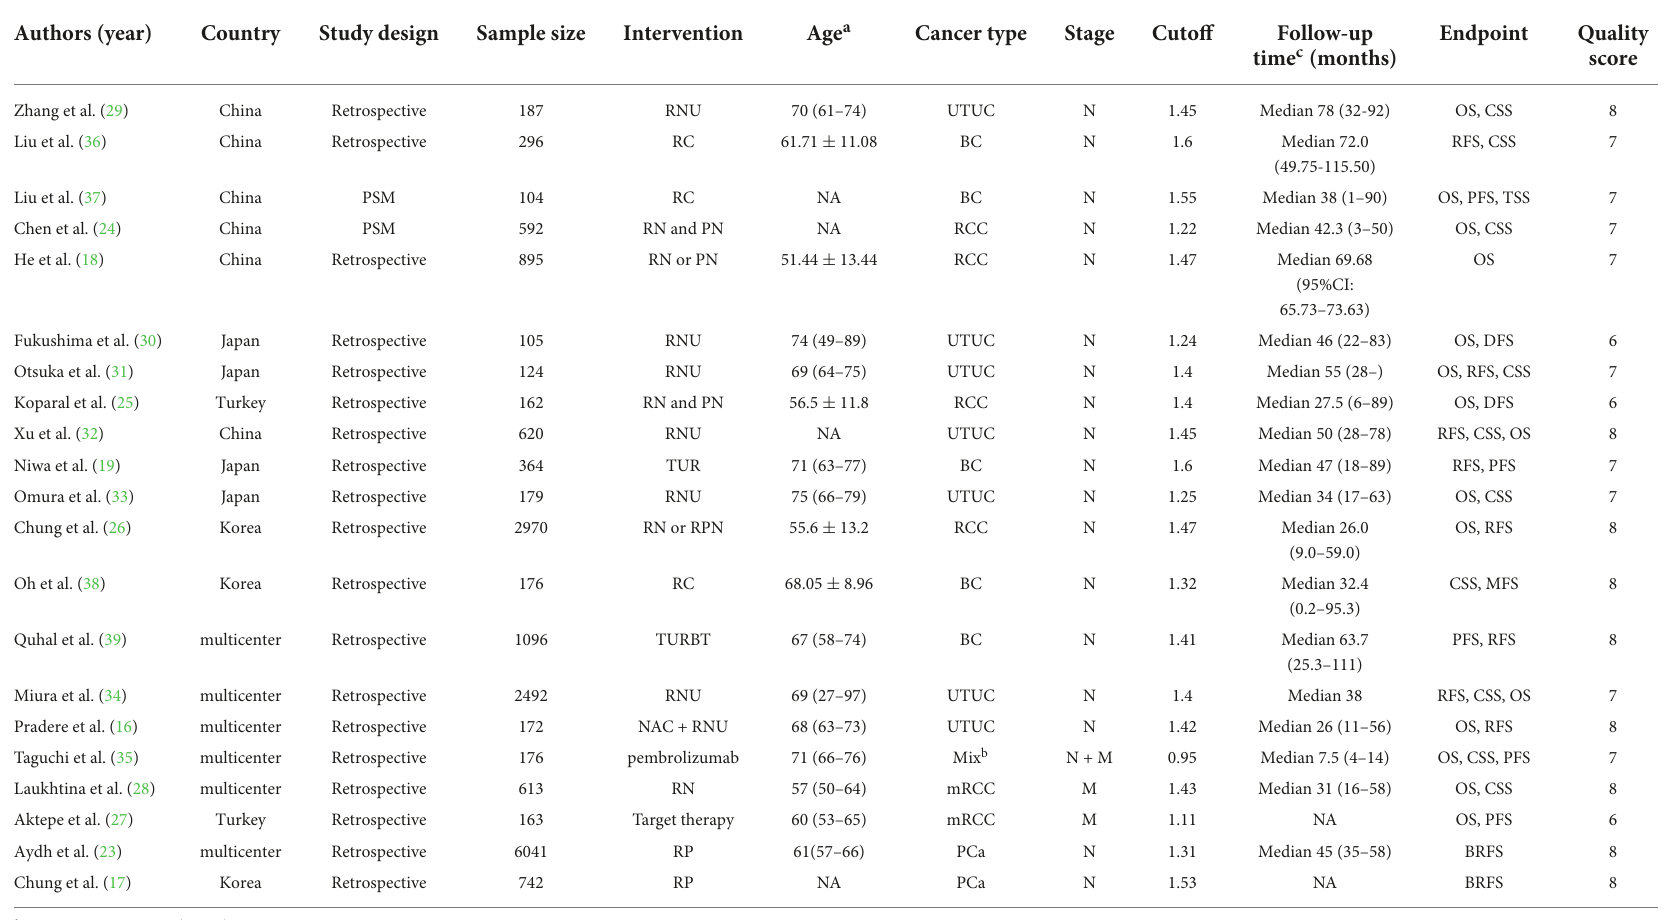
TABLE 1 Baseline characteristics of include studies and methodological